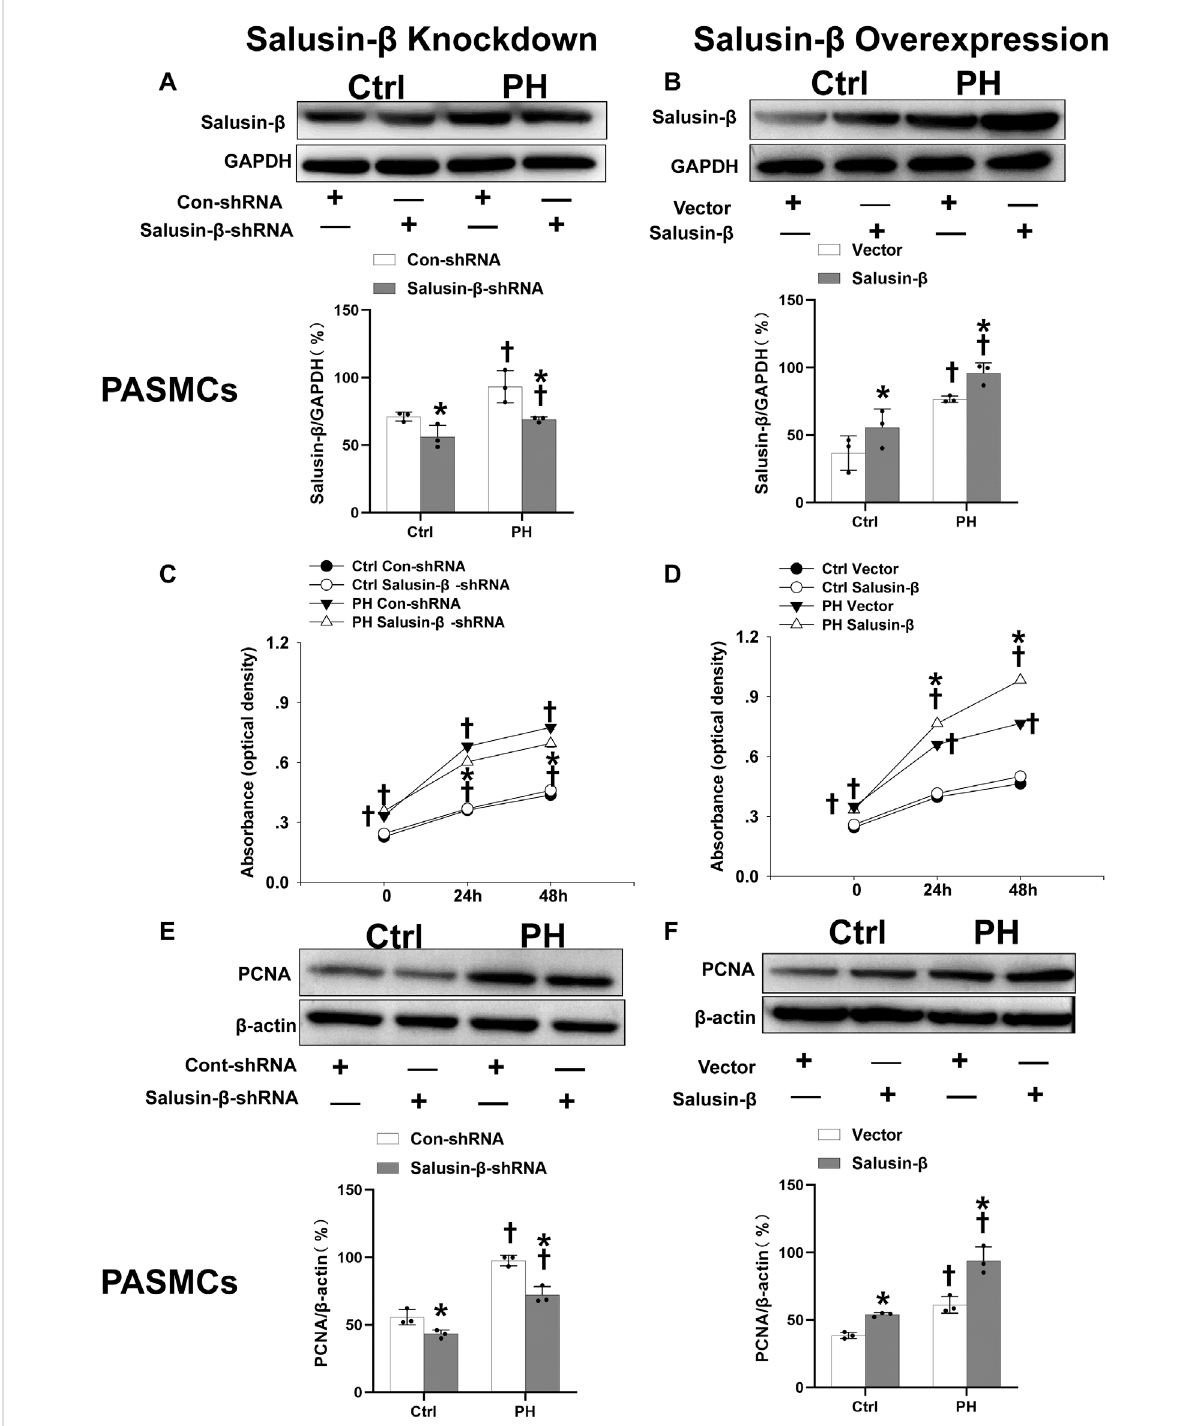
FIGURE 5 Effects of salusin- β knockdown on salusin- β protein expressions of PASMCs (A) , cell viability tested by CCK-8 assay (C) and protein expressions of proliferation marker proliferating cell nuclear antigen (PCNA) (E) ; as well as the effects of overexpression of salusin- β on salusin- β protein expressions (B) , cell viability tested by CCK-8 assay (D) and proliferation marker PCNA protein expressions (F) in PASMCs isolated from control and MCT-induced PH rats. Values are mean ± SE. * p < 0.05 compared with Con-shRNA or vector. † p < 0.05 compared with control (Ctrl) rats. n = 3 for A, B, E, and F groups. n = 6 for C and D